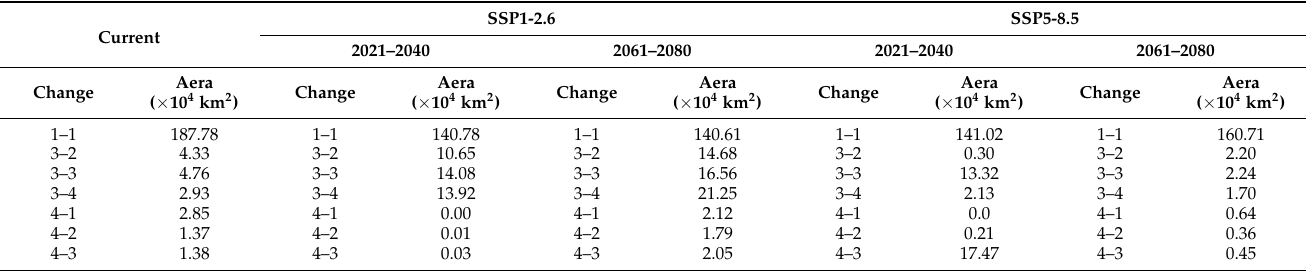
Figure 8. Changes in the potential distribution of P. yunnanensis and T. yunnanensis under different climate scenarios. (“1” indicates unsuitable areas, “2” indicates lowly suitable areas, “3” indicates moderately suitable areas, and “4” indicates highly suitable areas).